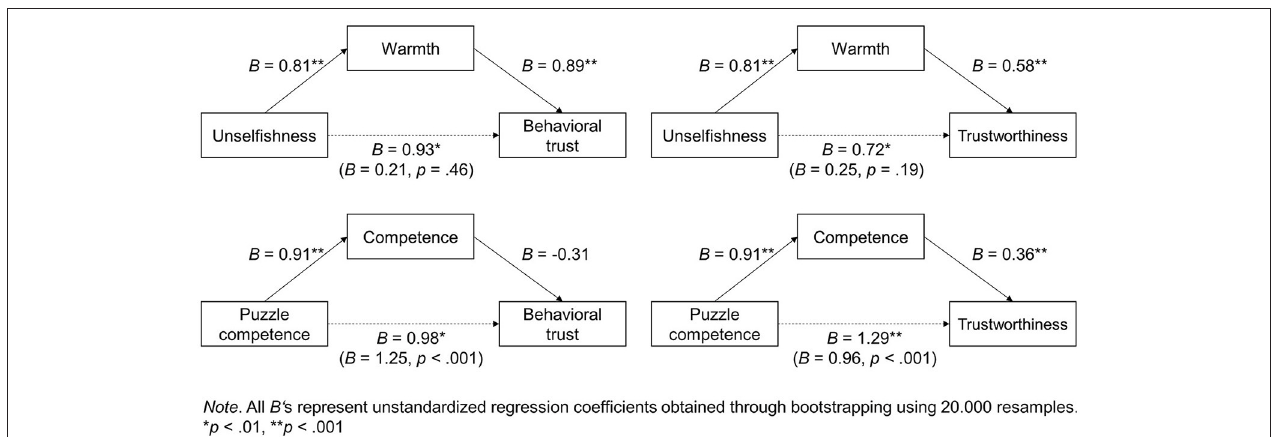
FIGURE 4 | The effect of unselfish (competent puzzle solving) behavior on behavioral trust and perceived trustworthiness, respectively, through perceived warmth